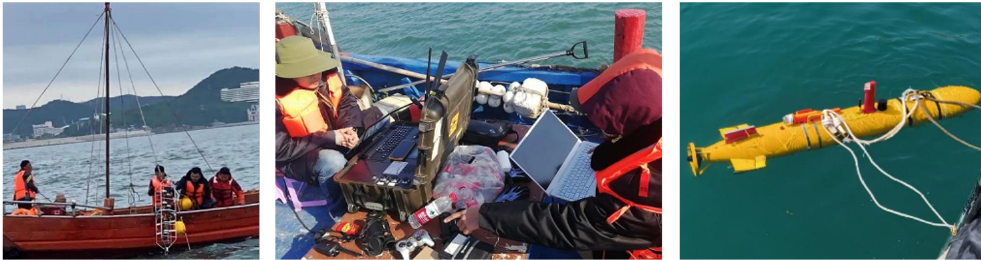
Figure 11. The records of the field